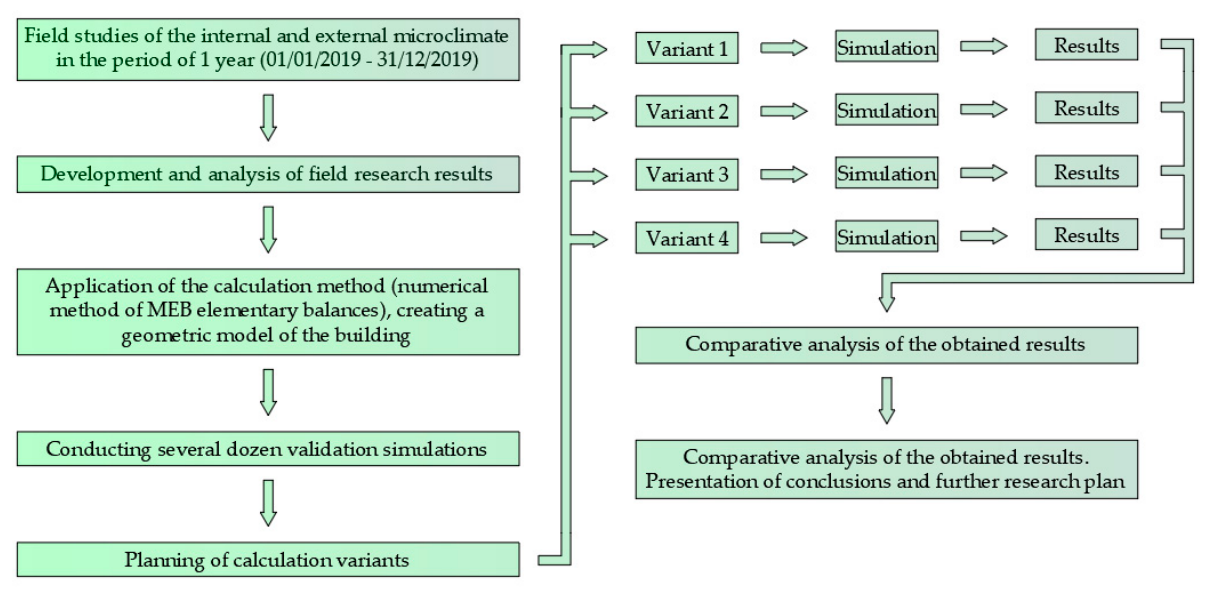
Figure 1. The conceptual framework of the study.